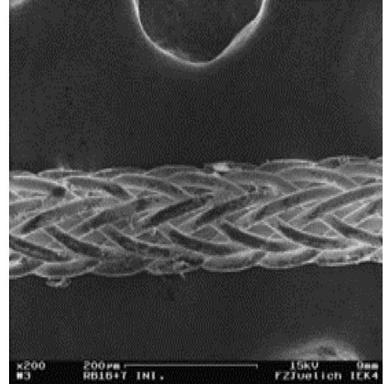
Braided fiber yarn (16+7 filaments).